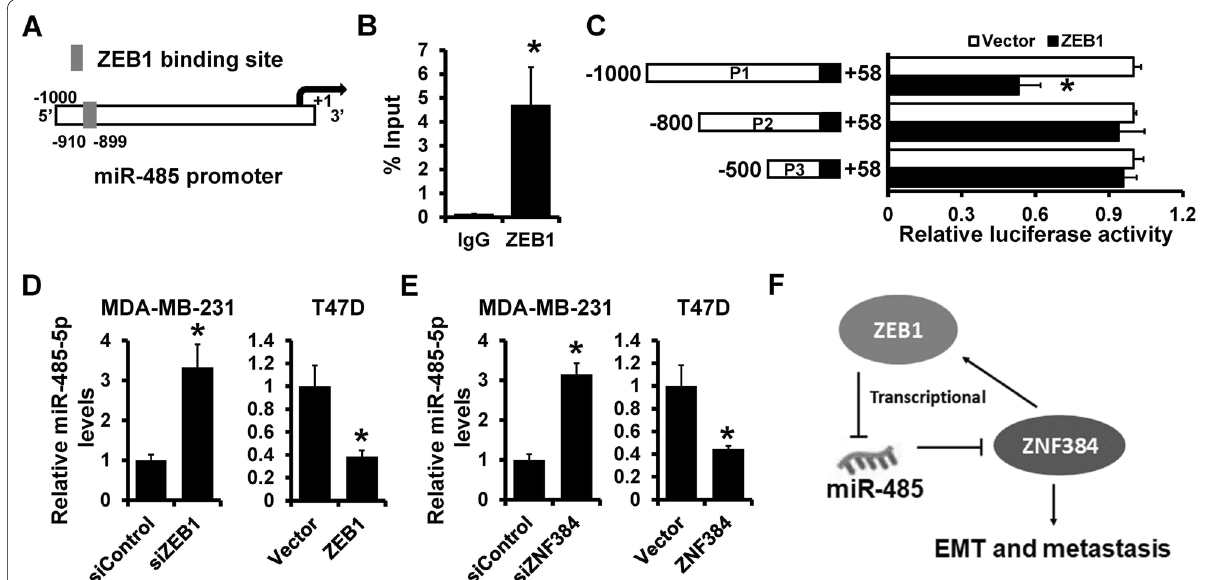
Fig. 7 ZEB1 represses miR‑485‑5p expression in a ZNF384–ZEB1 feedback loop. A A potential ZEB1‑binding site located in the miR‑485 promoter region. B The interaction between ZEB1 and miR‑485 promoter region in MDA‑MB‑231 cells verified by ChIP analysis. C The effect of ZEB1 expression on miR‑485 promoter activity determined by dual‑luciferase reporter analysis in 293FT cells. A series of fragments containing the predicted ZEB1 binding site is fused upstream of Luc gene. D The expression of miR‑485‑5p levels in ZEB1‑depleted MDA‑MB‑231 cells or ZEB1‑overexpressed T47D cells, as well as control cells, determined by RT‑qPCR. E The expression of miR‑485‑5p levels in ZNF384‑depleted MDA‑MB‑231 cells or ZNF384‑overexpressed T47D cells, as well as control cells, determined by RT‑qPCR. F Schematic illustration of ZNF384‑miR‑485‑5p feedback loop in regulating breast cancer EMT and metastasis. * P <